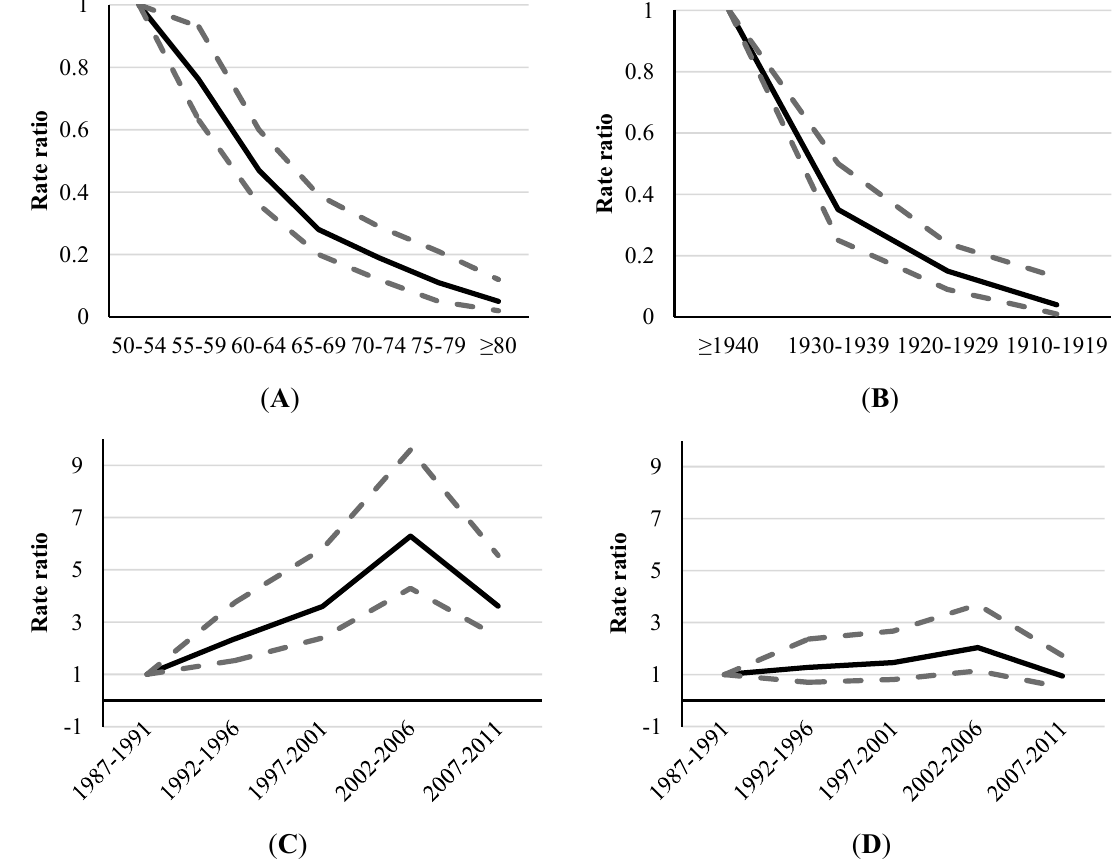
Figure 3. Adjusted rate ratios 1 of AIDS by age, period and birth-cohort (age ≥ 50 years), 1987–2011. ( A ) Age effect adjusted by sex and period; ( B ) Birth cohort effect adjusted by sex and period; ( C ) Period effect adjusted by sex and age; ( D ) Period effect adjusted by sex and birth